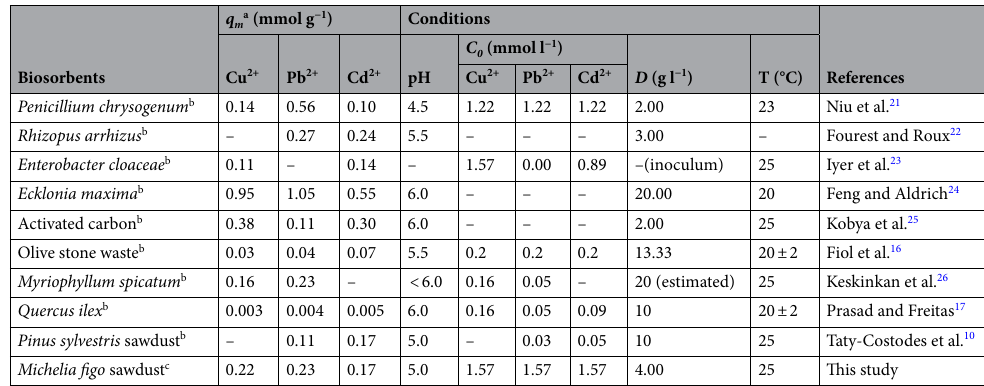
Table 3. The maximum adsorption capacities of different adsorbents. a The maximum adsorption capacity of biosorbent. b Capacity derived from isotherm study; c estimated capacity (single metal removal experiment); T: experimental temperature.